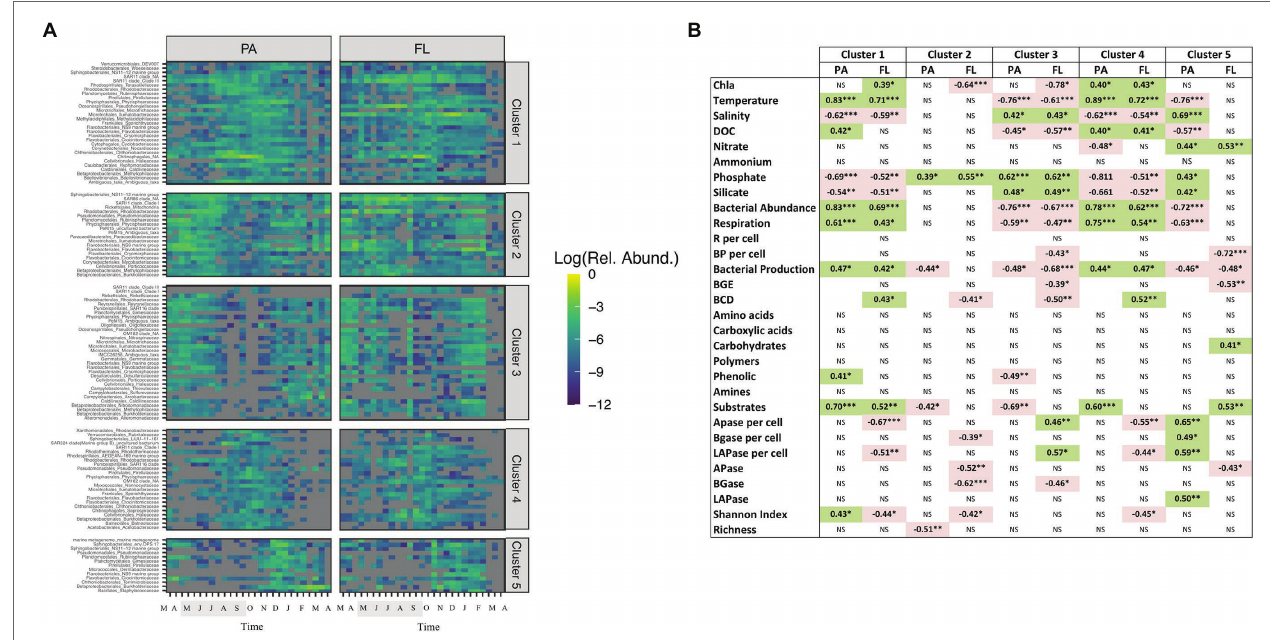
FIGURE 5 | (A) Temporal evolution of the 100 most abundant bacterial ASVs in the PA and FL size-fractions in clusters defined by Euclidean distances. The shaded period in the x-axis corresponds to summer. (B) Spearman’s correlations between the abundance of the different clusters generated in panel A and environmental variables and microbial abundance and activity in the two size-fractions studied. NS: not significant. Green background: positive correlation, red background: negative correlation. * p < 0.05; ** p < 0.01; and *** p <